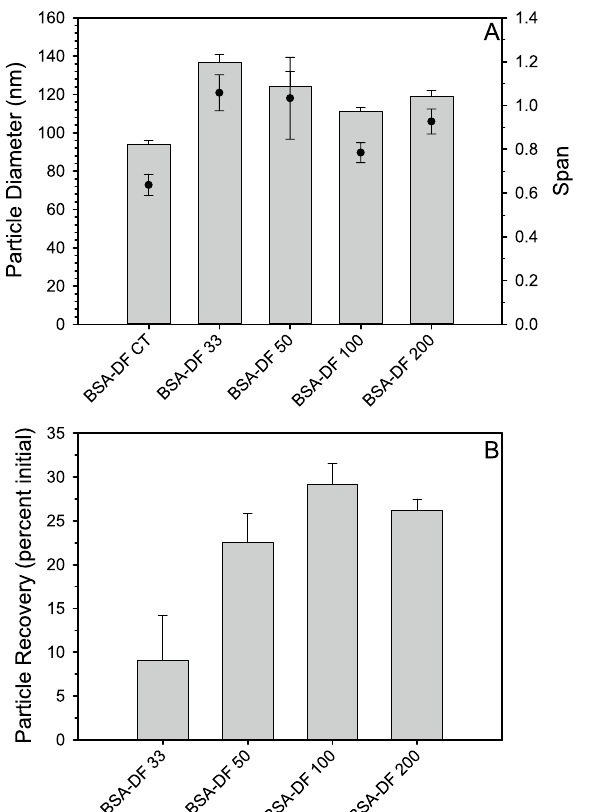
Figure 2. ( A ) Plots of mean diameter (grey bars) and Span (black circles) pre freeze-drying (BSA-DF) and after reconstitution at various particle concentrations for BSA nanoparticles fabricated with defatted protein. ( B ) Plot of particle recovery for freeze-dried BSA-DF nanoparticles at different concentrations upon reconstitution. Data represents mean values from three measurements and error bars represent the standard